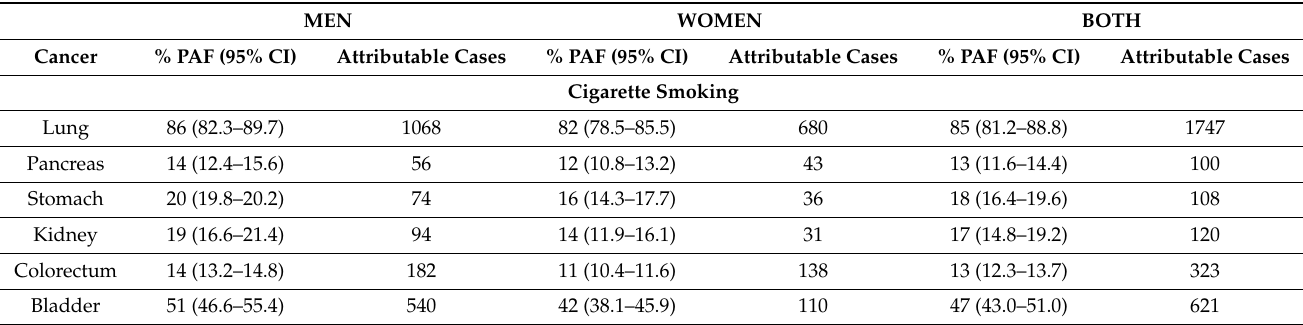
Table 3. Estimates cancer cases in Jewish adults aged 30 years and older in Israel in 2015 attributable to potentially modifiable risk factors by sex, risk factor, and cancer